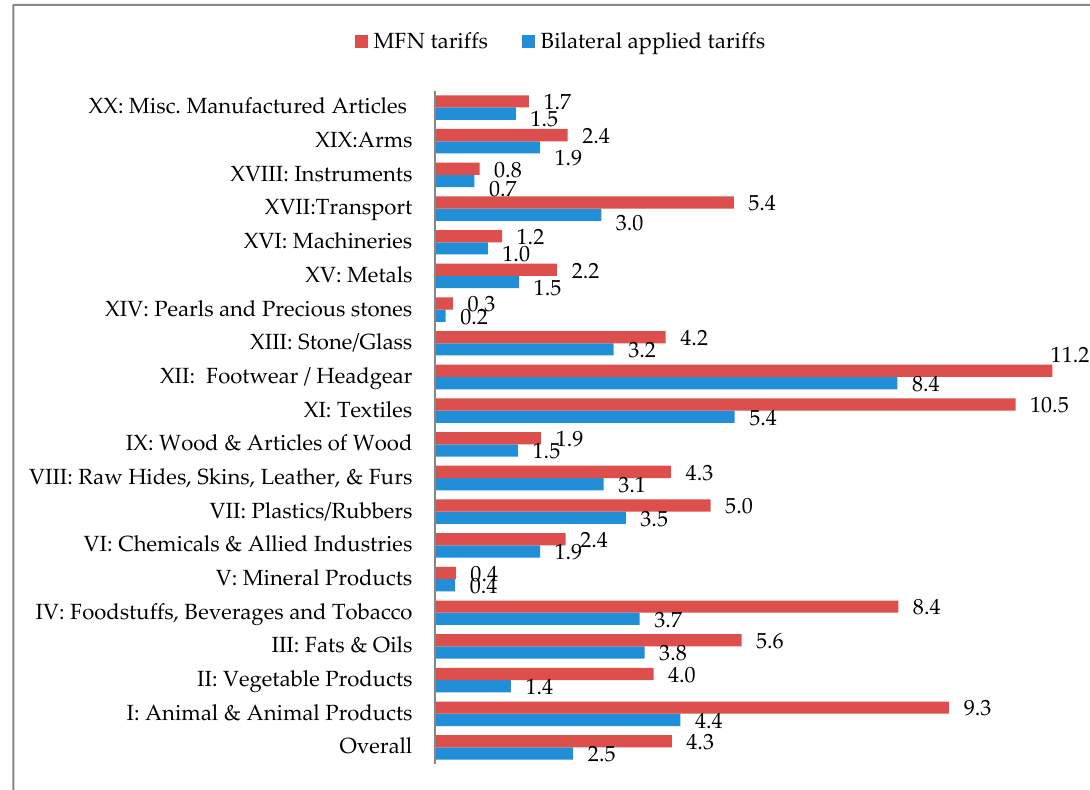
Figure 2. Tariffs (%, trade-weighted mean). Source: Elaboration on data by COMEXT and TRAINS; Figure 2. Tari ff s (%, trade-weighted mean). Source: Elaboration on data by COMEXT and TRAINS; 2017.